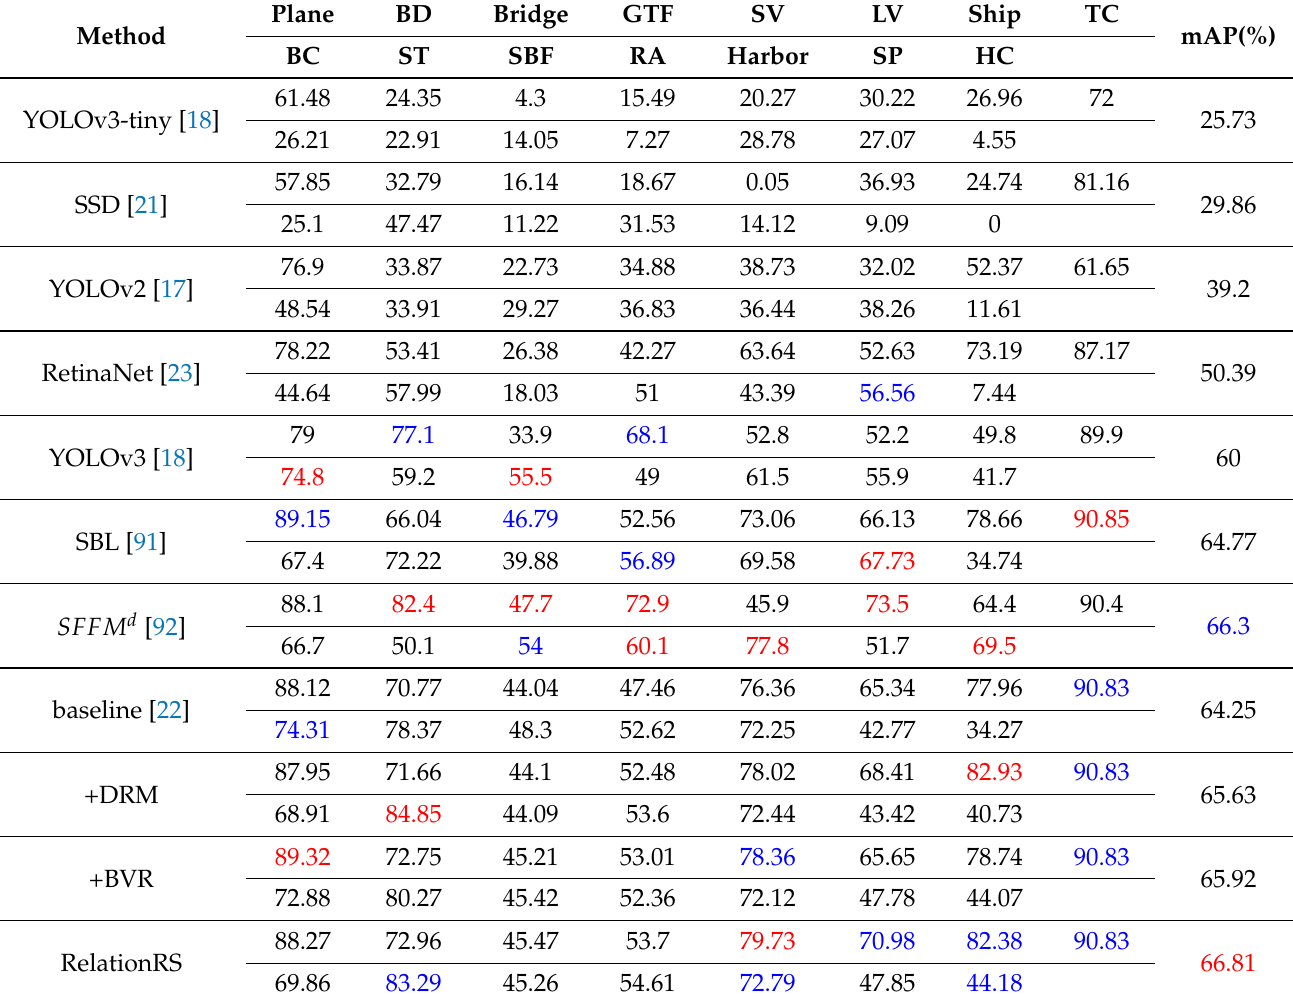
Table 3. Comparisons with the state-of-the-art single-stage-based detectors in the DOTA1.0 test dataset with horizontal bounding boxes. The baseline is the FCOS algorithm. +DRM means the combination of the FCOS and the dual relationship module. +BVR is a combination of the baseline method and the bridging visual representations module, and the RelationRS is a network adding the DRM and the BVR module to the baseline detector. The red numbers and the blue numbers denote the highest values and the second highest values in each